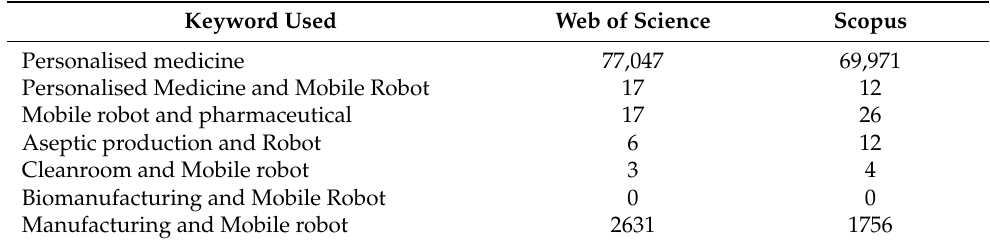
Table 3. Number of indexed research articles related to biomanufacturing and personalised medicine as of the seventh of June 2022.